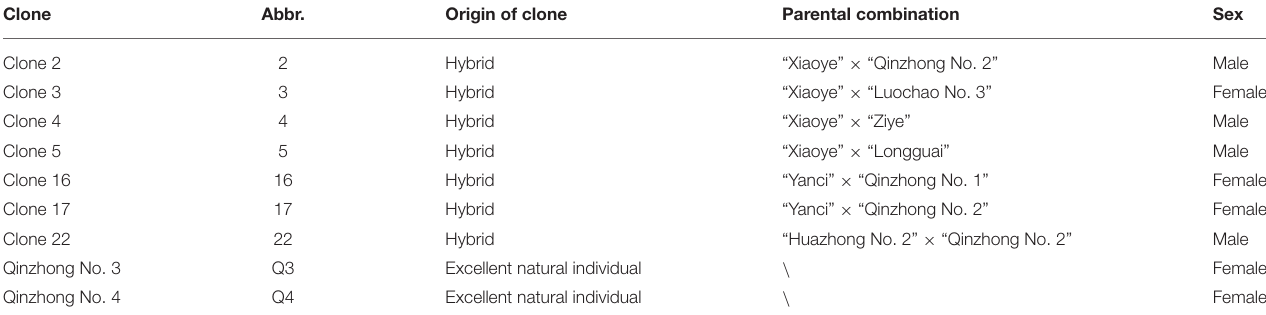
TABLE 1 | The sources of the clones.